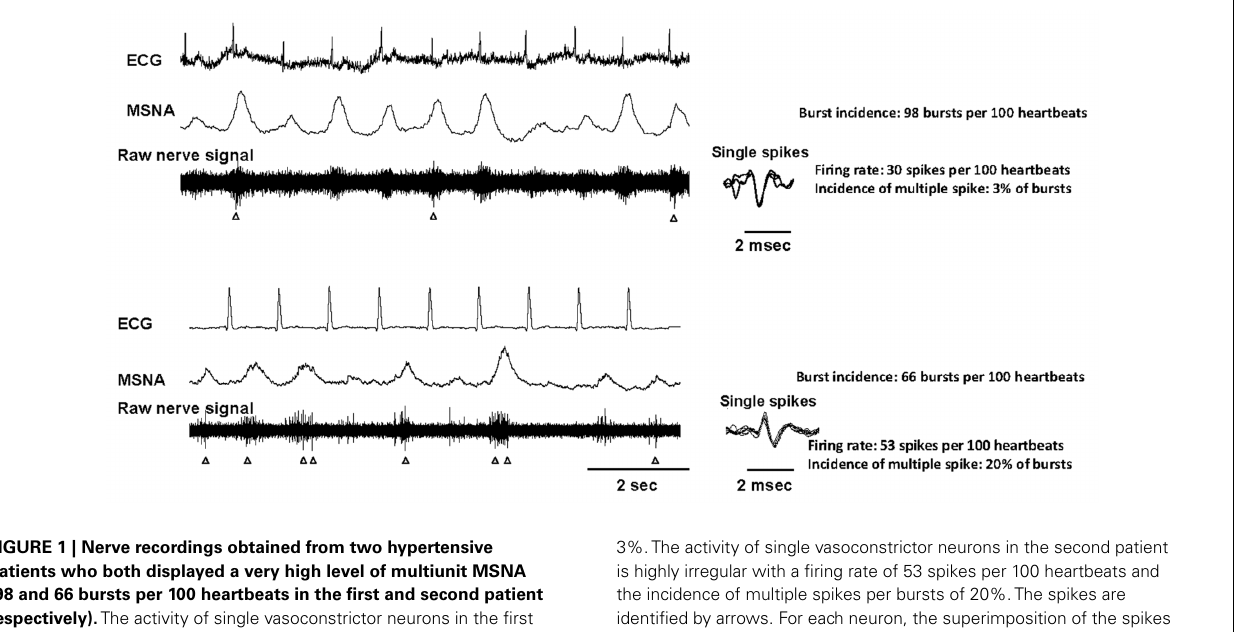
FIGURE 1 | Nerve recordings obtained from two hypertensive patients who both displayed a very high level of multiunit MSNA (98 and 66 bursts per 100 heartbeats in the first and second patient respectively). The activity of single vasoconstrictor neurons in the first patient is relatively low and regular, with the firing rate being 30 spikes per 100 heartbeats and the incidence of multiple spikes per bursts being